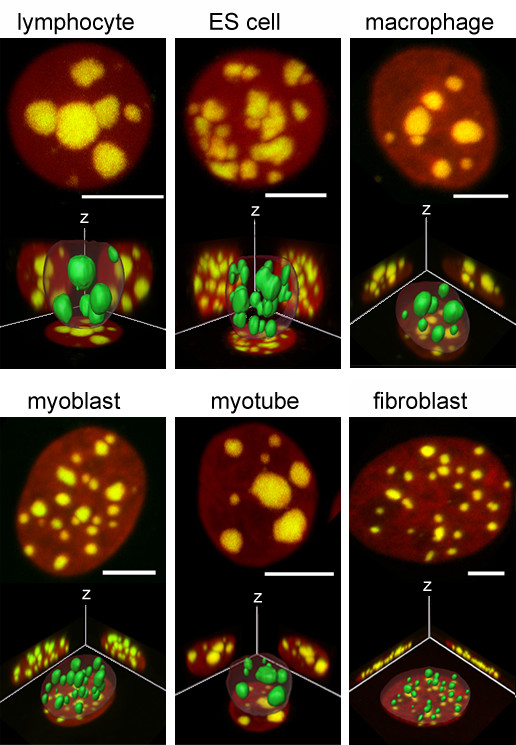
3D-FISH with the mouse major satellite DNA probe. For each cell type, maximum intensity xy-projections (top) and 3D-reconstructions (bottom) are shown. In the projections, DNA counterstain (TO-PRO3) is shown in red and FISH signals are false-colored in green. Overlap of both signals in chromocenters leads to the intense yellow color. Scale bars represent 5 μm in the respective projection. The 3D-reconstructions (not to scale) are shown together with xy, xz and yz maximum intensity projections in the background. Chromocenters in the reconstructions are shown as solid green structures, while the nuclear border is presented as a transparent shell. Note the differences in number and size of chromocenters in the various cell types and the differences in nuclear shape.